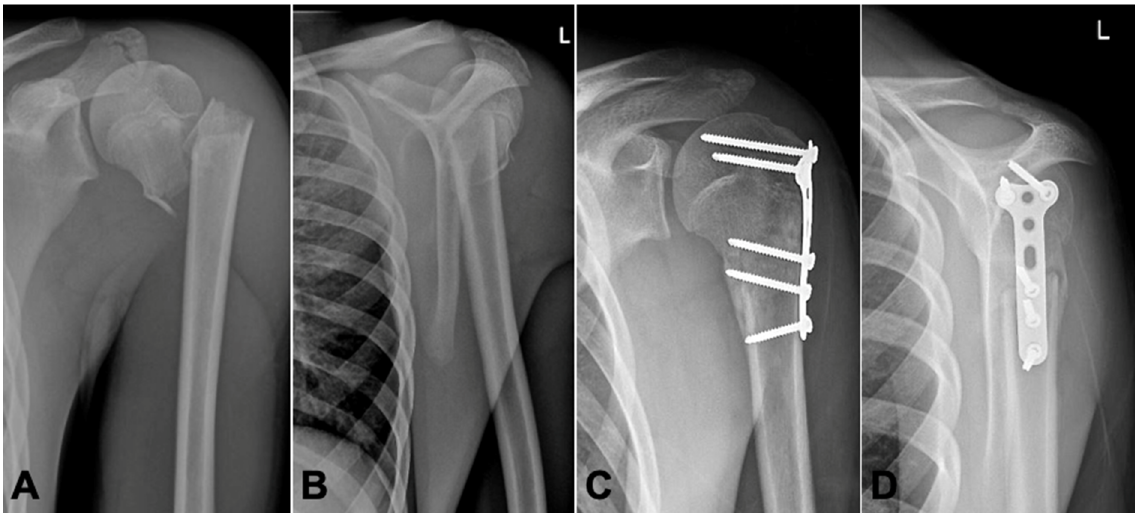
Figure 1. Radiographic shoulder views (Pat. N° 4) (ap/Neer). ( A , B ): Dorsally displaced humeral head. ( C , D ): 10 weeks after open reduction and plate fixation.